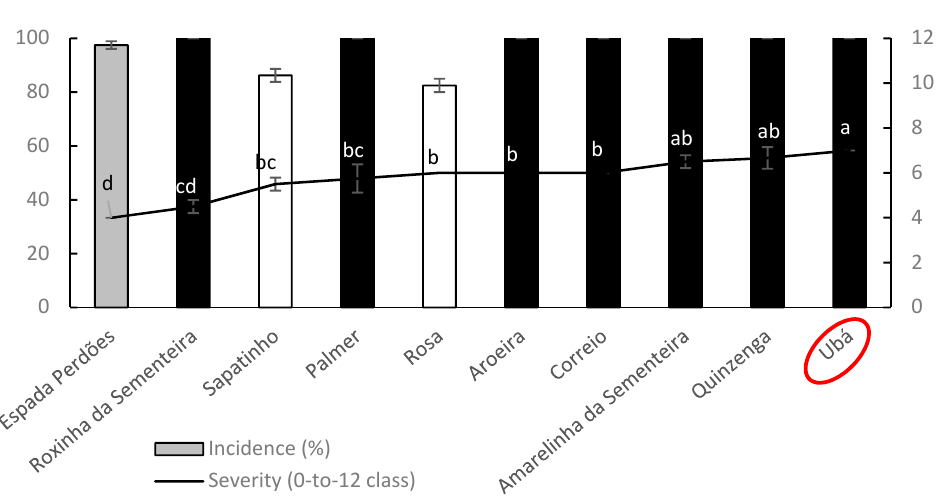
Figure 10. Column-line graphs on two axes comparing anthracnose incidence and severity caused by C. asianum within highly sensitive mango cultivars. Data (± SE values) were collected and analyzed as above done for previous figures. Grey colors of columns, as well as the absence of letters above points of the line, clearly shows the lack of significant differences according to both parametric and nonparametric approaches.